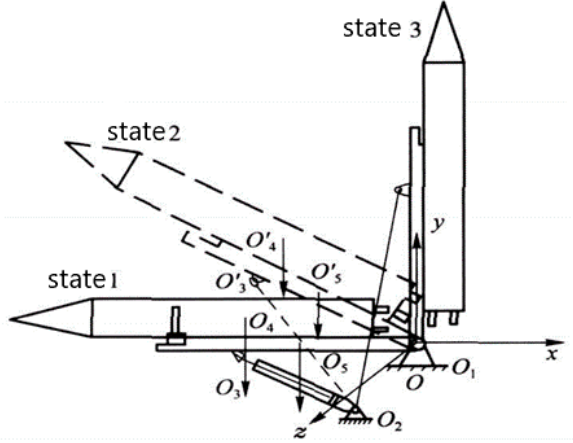
Figure 1. The schematic diagram of vertical equipment.